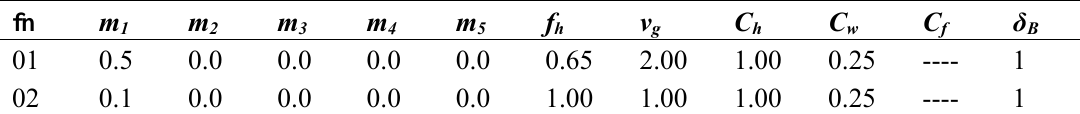
Table 1. Fuels data for Rabbit Rules: fn01—grass/pine needle mixture, fn02—grass only. fn m m m m m f v C C C δ 1 2 3 4 5 h g h w f B 01 0.5 0.0 0.0 0.0 0.0 0.65 2.00 1.00 0.25 ---- 1 02 0.1 0.0 0.0 0.0 0.0 1.00 1.00 1.00 0.25 ----